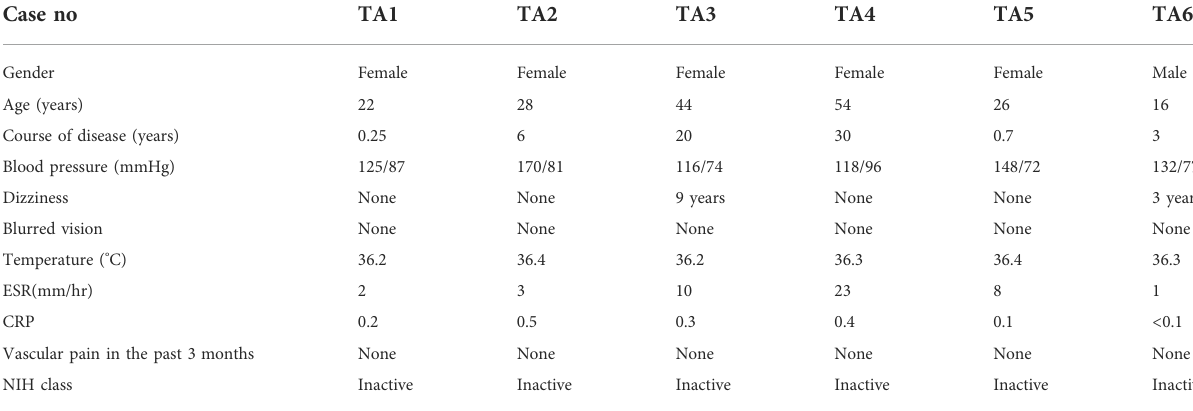
TABLE 1 Clinical Characteristics of TA patients.